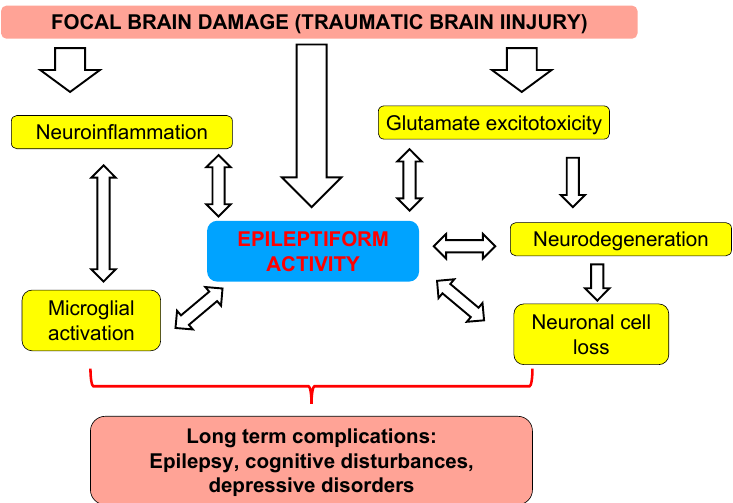
Figure 8. Putative interconnections among EDs and key mechanisms of remote hippocampal damage. Understanding the mechanisms of distant hippocampal damage is essential for the development of pathogenetically justified new treatment strategies to predict and prevent long-term consequences of TBI.